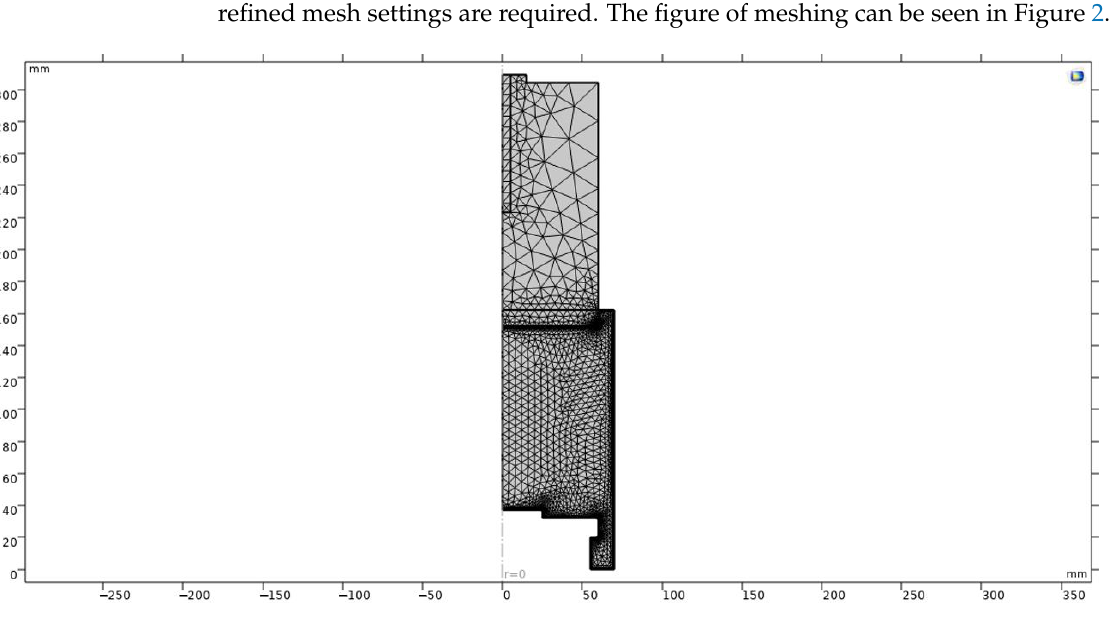
Figure 2. Mesh generation.